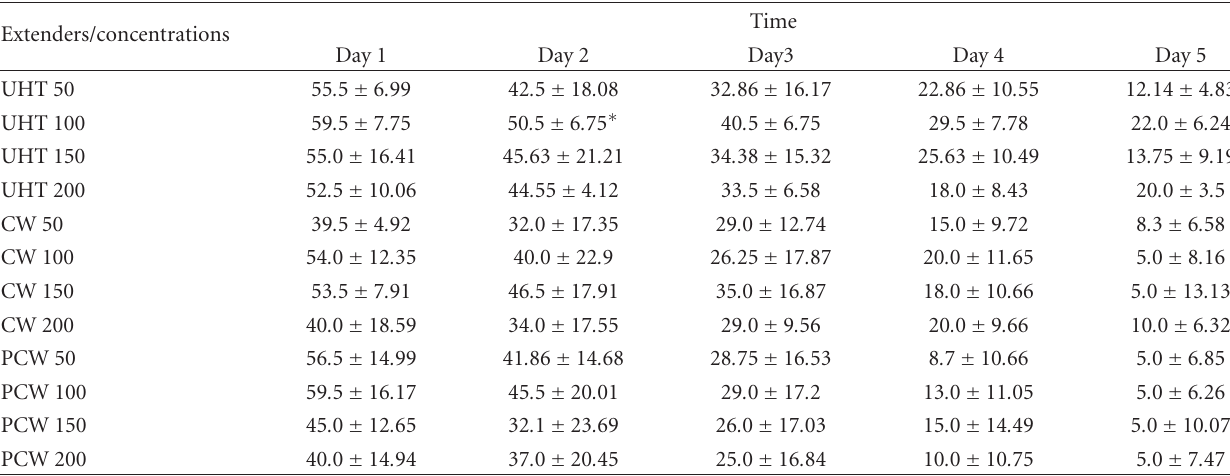
Table 1: Data table for Figure 1 listing means ± SD for FPM% over time. Extenders/concentrations